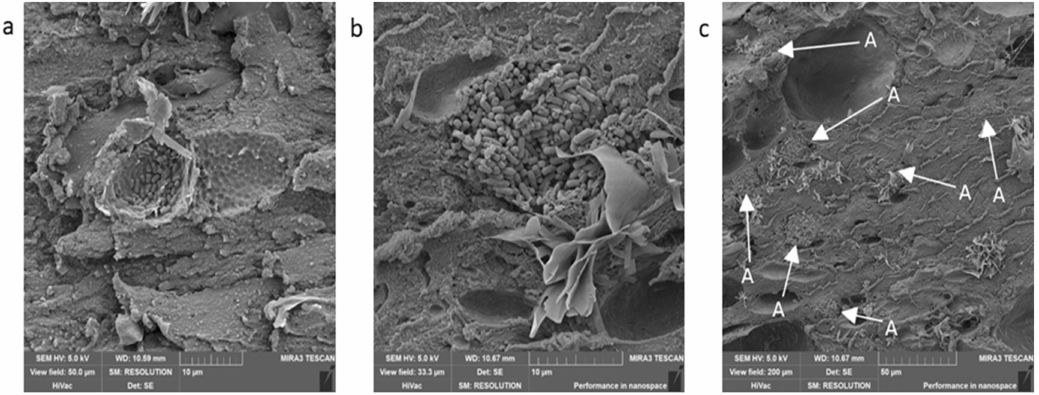
Figure 6. Lactic acid bacteria; ( a )—procedure 1; ( b , c )—procedure 2; A—arrangement of colonies of lactic acid